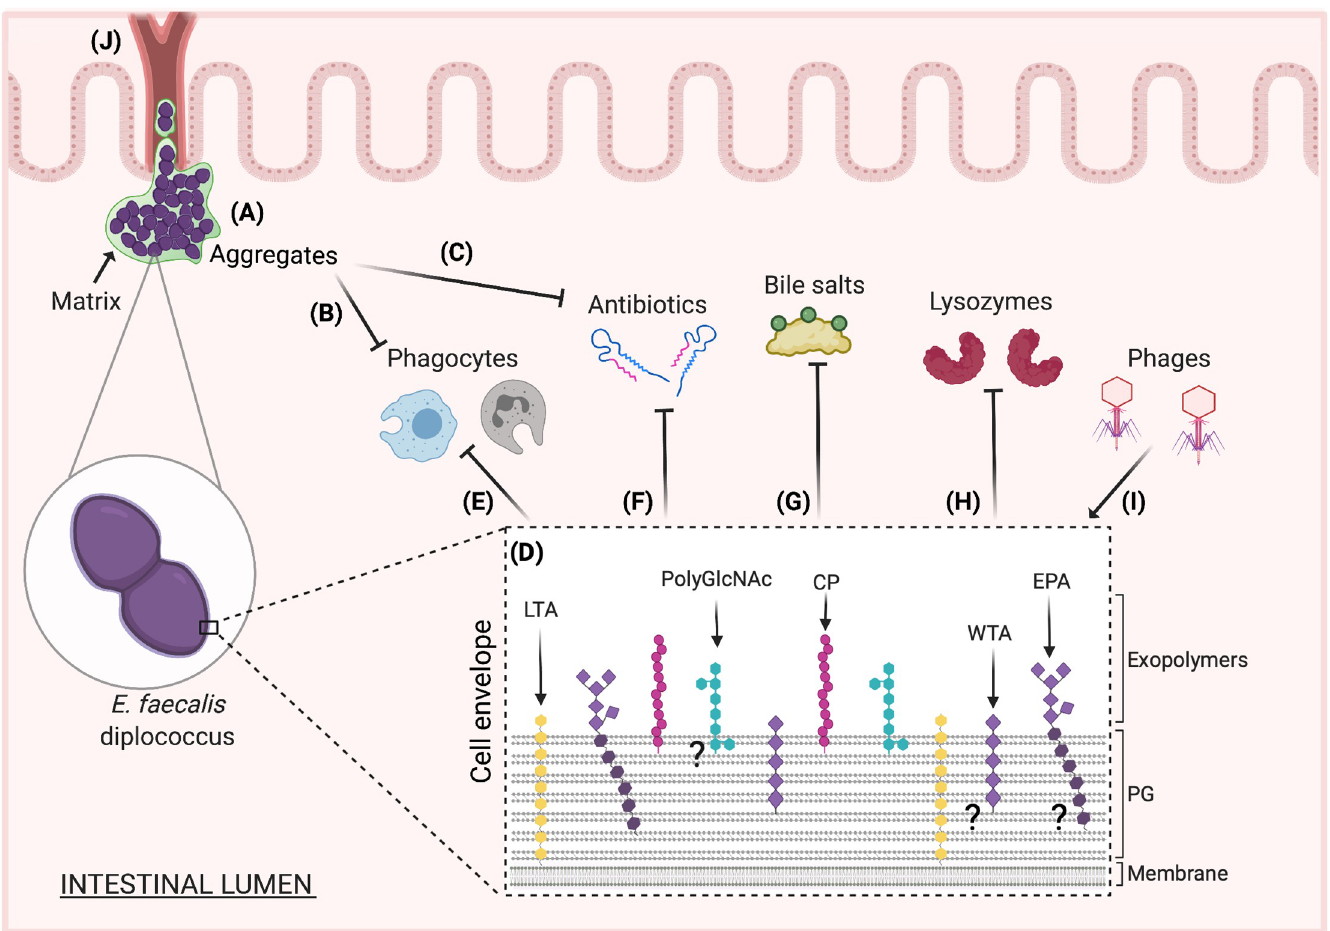
Fig 1. Proposed physiological roles of Enterococcus faecalis polysaccharides in the gut. (A) E . faecalis intestinal colonization has been proposed to be mediated by the formation of multicellular aggregates covered with and connected by a matrix (green) partly composed of exopolysaccharides [34,69]. (B) Formation of these complex communities may allow enterococci to evade the immune system by promoting survival within phagocytes (macrophages or neutrophils) and (C) to resist the effect of antibiotics produced by other gut bacteria. (D) Cells within these complex communities possess a variety of glycopolymers that promote aggregate formation and structural development [25]. Among these polymers, PG creates a layer that protects cells from osmotic pressure, reinforces cell shape and size, and shelters cell envelope components, including other structural/nonstructural polysaccharides [28]. The proposed scheme was based on previous publications [7,10,11]and shows an enterococcal cell envelope with relative glycobiological arrangements and positions. These glycopolymers, from left to right, include the membrane-anchored LTA (yellow), the exopolysaccharides containing polyGlcNAc (cyan), the covalently PG-bound CP (fuchsia), the WTA (light purple) that may also be bound to PG, and the EPA, which possesses a rhamnan backbone (dark purple) possibly anchored to PG and extracellular exposed WTA decorations (light purple). (E) WTAs, LTAs, EPA, and/or CPs allow E . faecalis to evade phagocytosis by macrophages or neutrophils [24,76,80,81,84–86].These cell envelope components likely act as a shield that prevent complement detection and mediate resistance to phagocytosis. Changes to these polysaccharides may disrupt the cell envelope topography, leaving the bacteria naked or likely exposing “neoepitopes” for recognition by the complement system. (F) Changes in PG and EPA structure or composition may also be contributing factors in the resistance to antibiotics, such as those targeting the enterococcal cell envelope [13,17,20,24,53,55,57]. (G) E . faecalis may resist the intestinal bile salt toxicity through rearrangements in the composition of EPA and/or PG that counteract the detergent activity of these amphipathic molecules and the induced external osmotic pressure. (H) This bacterium can evade the immune response and persist in the gut by resisting the antimicrobial effect of lysozymes through modifications of their PG structure [81,95–97]. (I) EPA also acts as a “receptor” that is recognized by phages during viral infection, and changes in EPA decoration can confer resistance to these phages by E . faecalis [18,47]. (J) Upon intestinal overgrowth, this bacterium can exit the intestinal lumen to reach the bloodstream and colonize distal anatomical sites. The formation of matrix-covered enterococcal aggregates may represent a new mechanism that promotes E . faecalis translocation across the gut epithelial barriers in susceptible hosts, where EPA or/and polyGlcNAc-containing exopolymers may facilitate this migration. (?) denotes that the exact localization of EPA, polyGlcNAc- containing polysaccharides, and WTA in the enterococcal cell envelope is uncertain. C AU : AbbreviationlistshavebeencompiledforthoseusedthroughoutFigs 1 and 2 : Pleaseverifythatallentriesarecorrect : P, capsule polysaccharide; EPA, enterococcal polysaccharide antigen; LTA, lipoteichoic acid; PG, peptidoglycan; polyGlcNAc, β -(1,6)-GlcNAc polymers; WTA, wall teichoic acid.